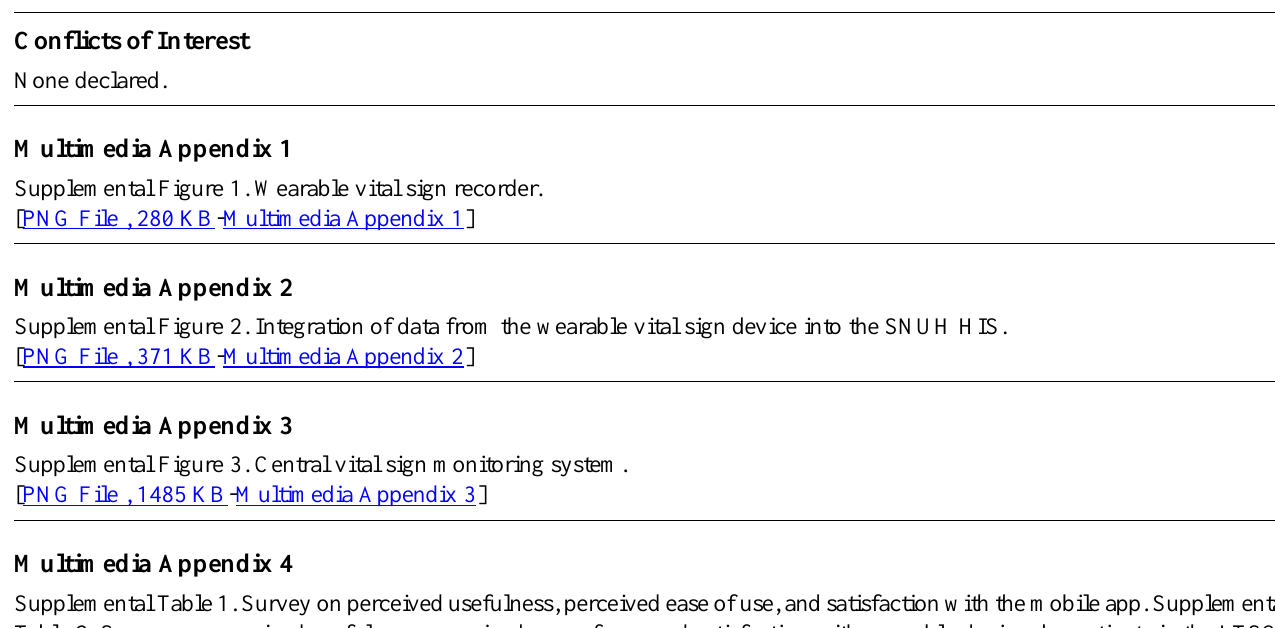
Supplemental Figure 1. Wearable vital sign recorder.